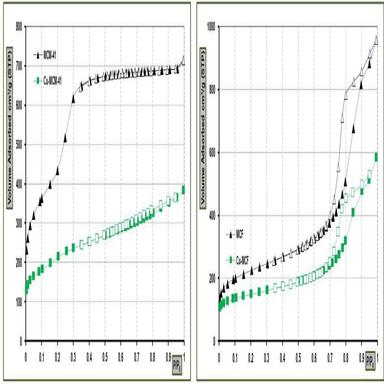
Nitrogen adsorption isotherms at 77 K, of raw MCM-41 and Cu-MCM-41(left) and MCF and Cu-MCF (right).